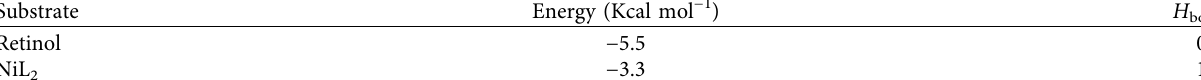
bonds ) from Autodock analysis of retinol and NiL 2 complex.